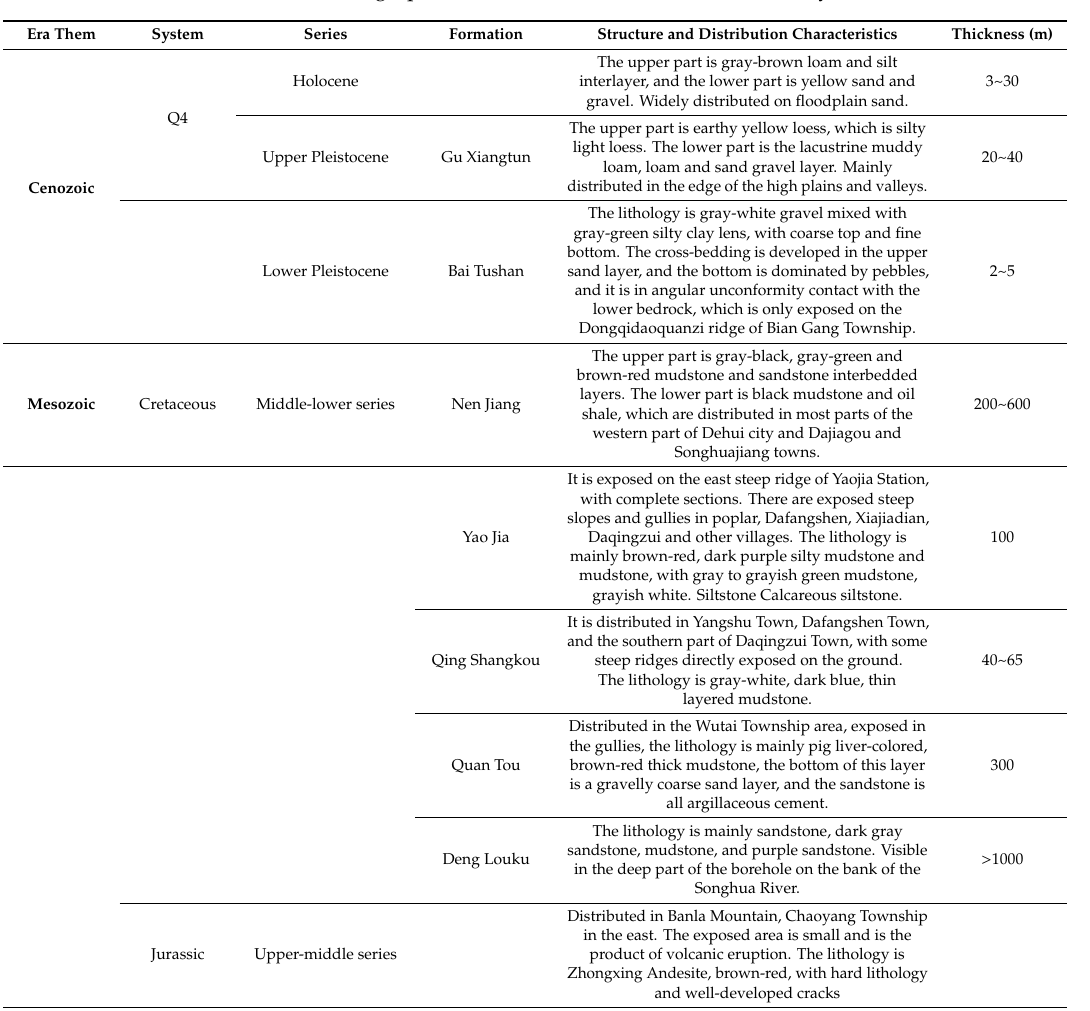
Table 1. Stratigraphic structure characteristics of Dehui